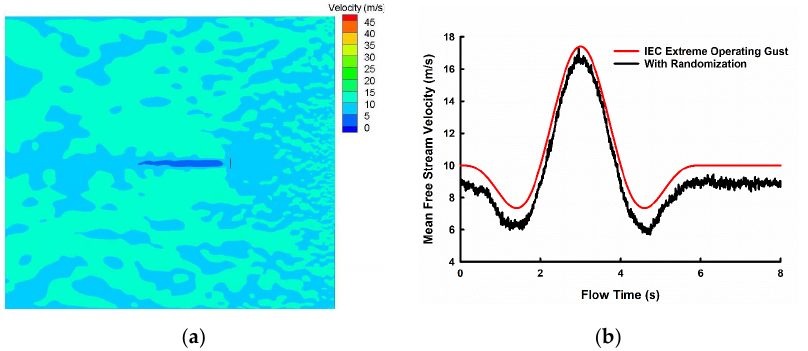
Figure 1. ( a ) Velocity contour of non-uniform flow upstream of the VAWT; ( b ) Temporal variation of average free stream wind velocity upstream of the VAWT.